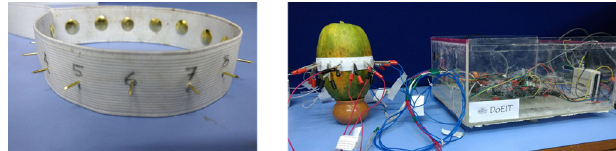
Fig.4: (a) Modified electrode interface (b) Papaya under test with electrodes